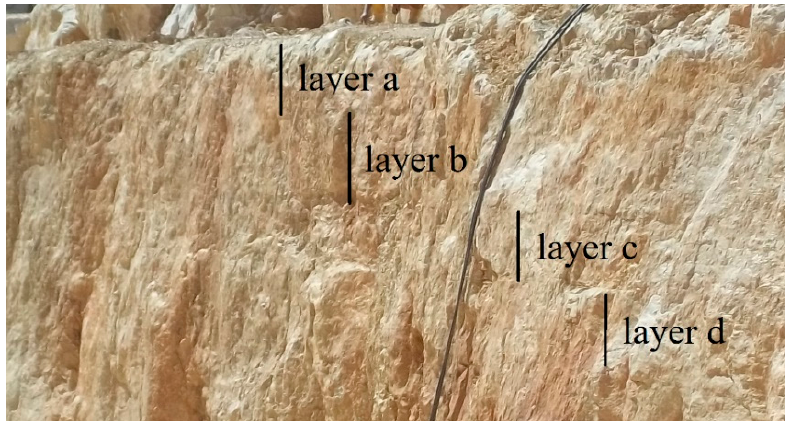
Figure 3. A left-side view of the bench face where horizontal layers were observed visually (named a, b, c, and d).